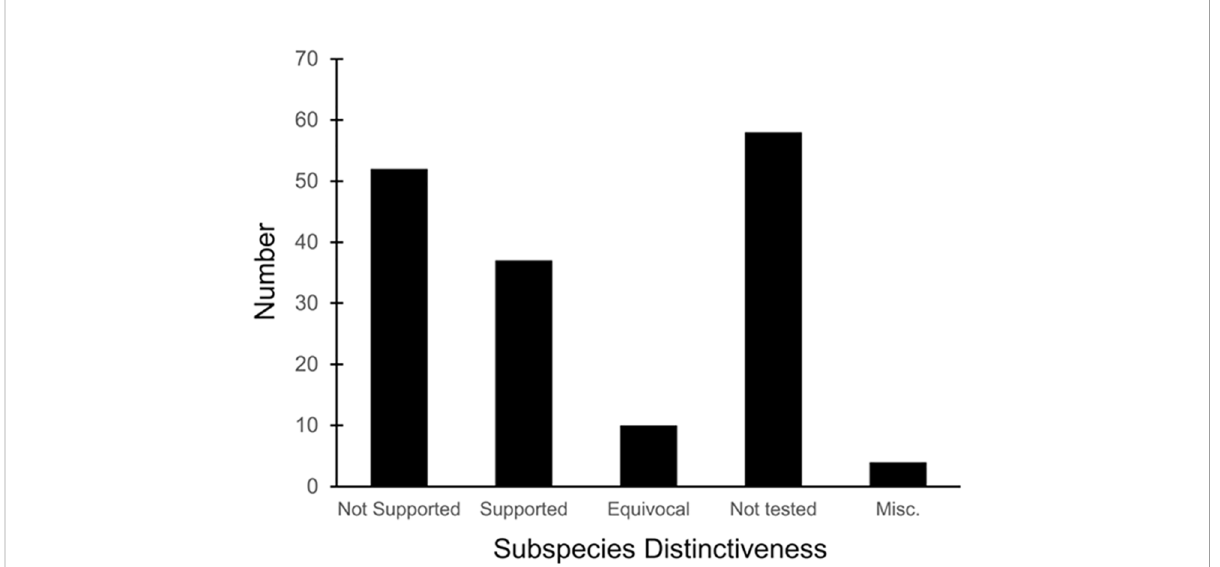
FIGURE 2 Distribution of results of evaluation of listed vertebrate subspecies. “ Not tested ” means samples from listed subspecies were not compared with samples from adjacent subspecies, there were too few samples, or samples were not